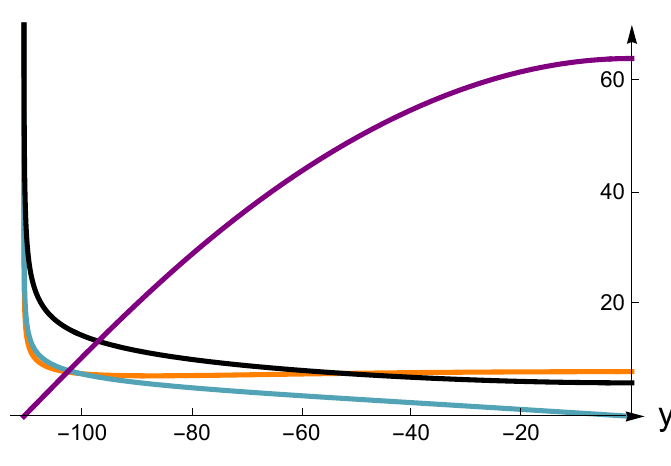
Figure 3 . A numerical solution with M 6 an S 3 -fibration over a three-manifold Σ 3 , interpolating between an O8-plane on the left, and a regular point on the right. The functions are e A (orange), e B (aqua), e C (black), h (purple). The parameters in (6.58) in this case are a 0 = 8 , c 0 = 4 , R 0 = 6 , m = 1